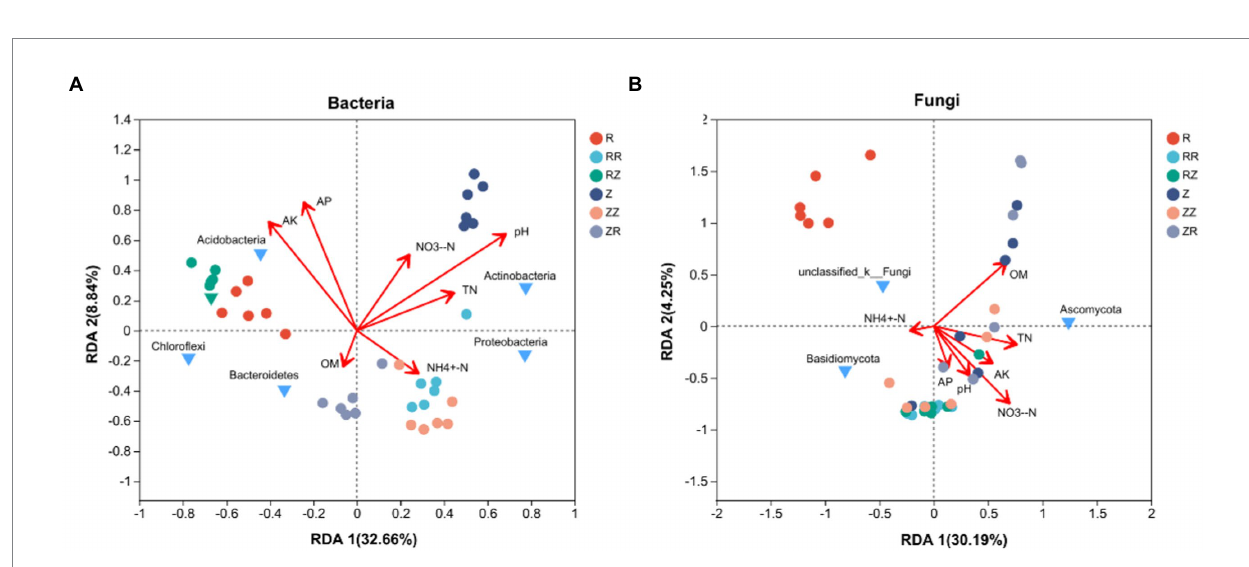
FIGURE 7 Distance-based redundancy analysis (dbRDA) Redundancy analysis of (A) bacteria and (B) fungi with environmental factors on different sugarcane